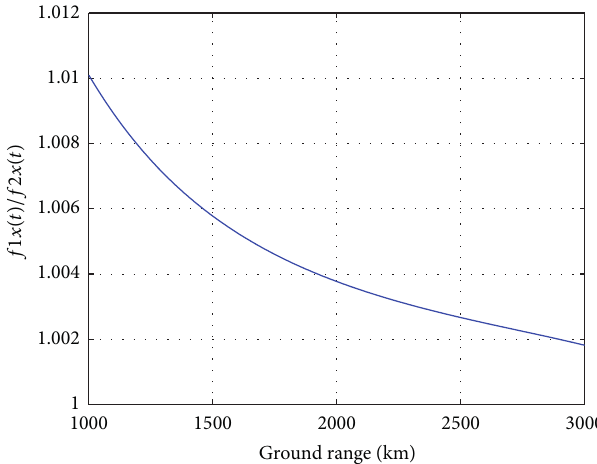
Figure 7: The ration of 11x to